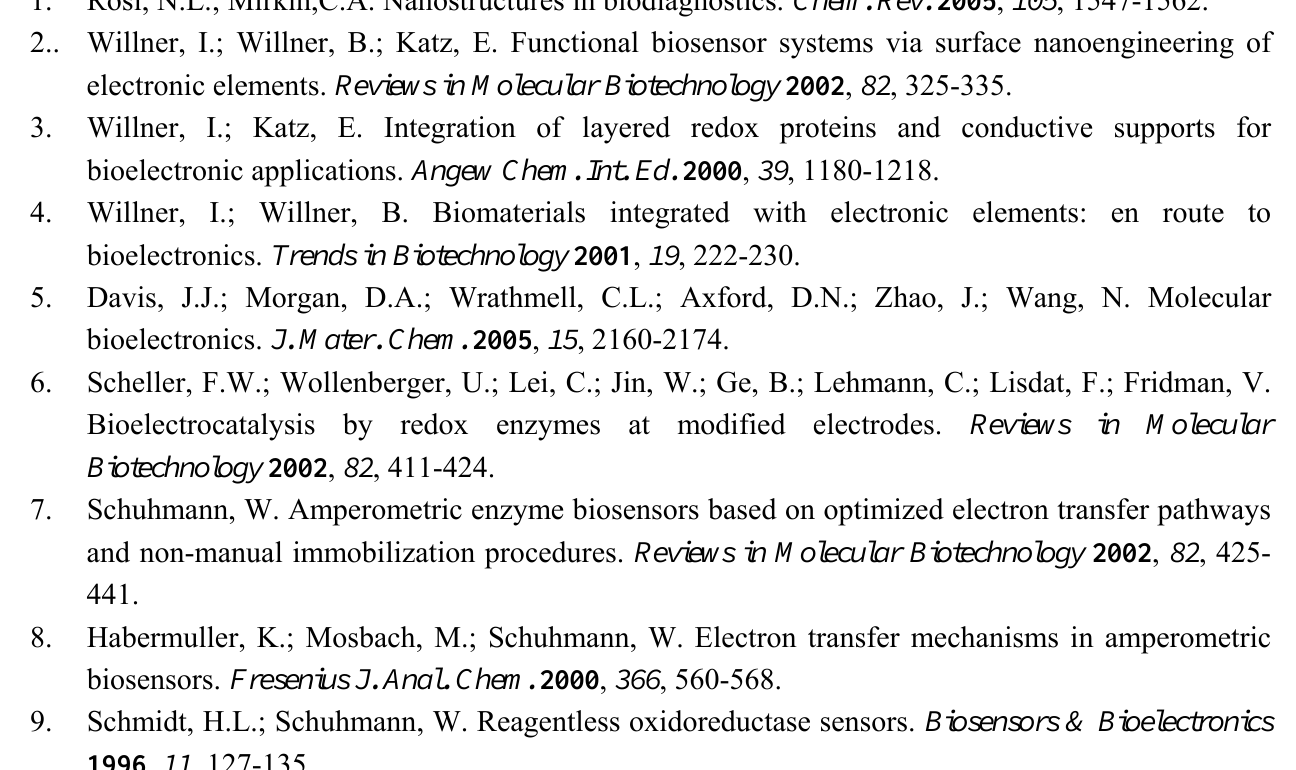
Dimensionless concentration of reduced enzyme Dimensionless concentration of reduced enzyme at electrode surface. Dimensionless concentration of oxidized mediator. Dimensionless concentration of oxidized mediator at electrode surface. Distance variable (unit: cm). Non dimensional distance variable. Normalised electrode potential. Normalised reaction flux for enzyme electrode. Normalised flux arising from turnover of mediator by the substrate. Normalised flux at electrode/solution